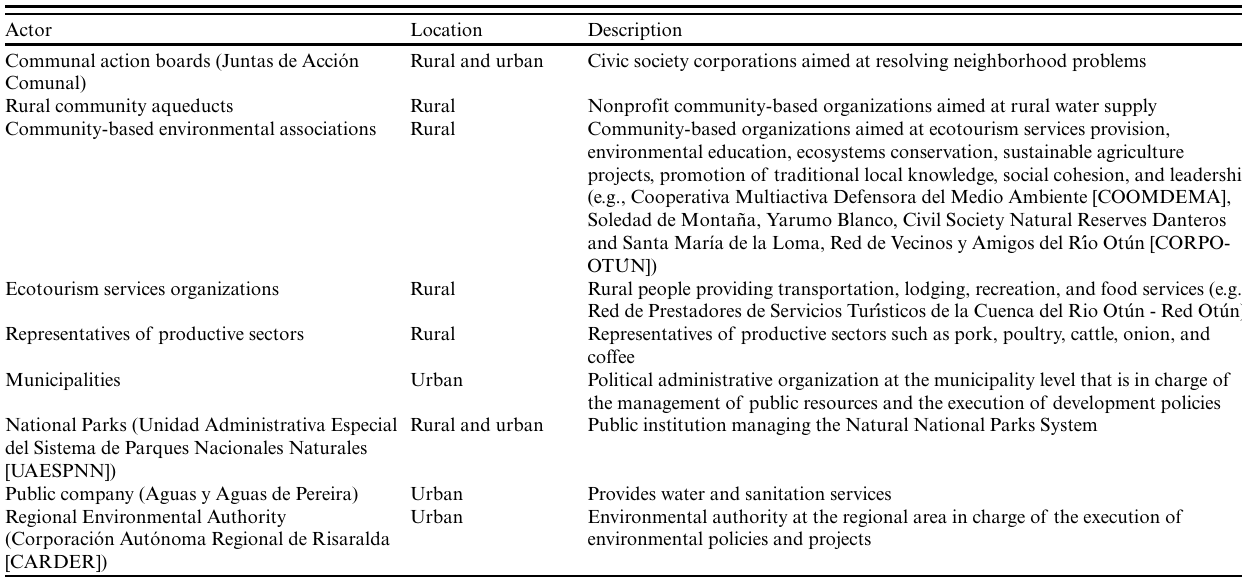
Table 1. Main actors of the mid-upper stream of the Otún River watershed,